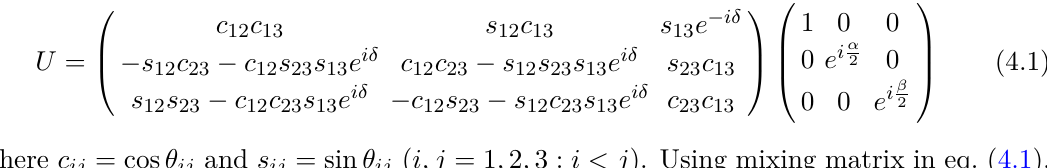
Figure 1 . Variation of Yukawa couplings of modular weight 2 ( | Y 2 ure 1(a)) and Imaginary part (figure 1(b)) of complex modulus τ